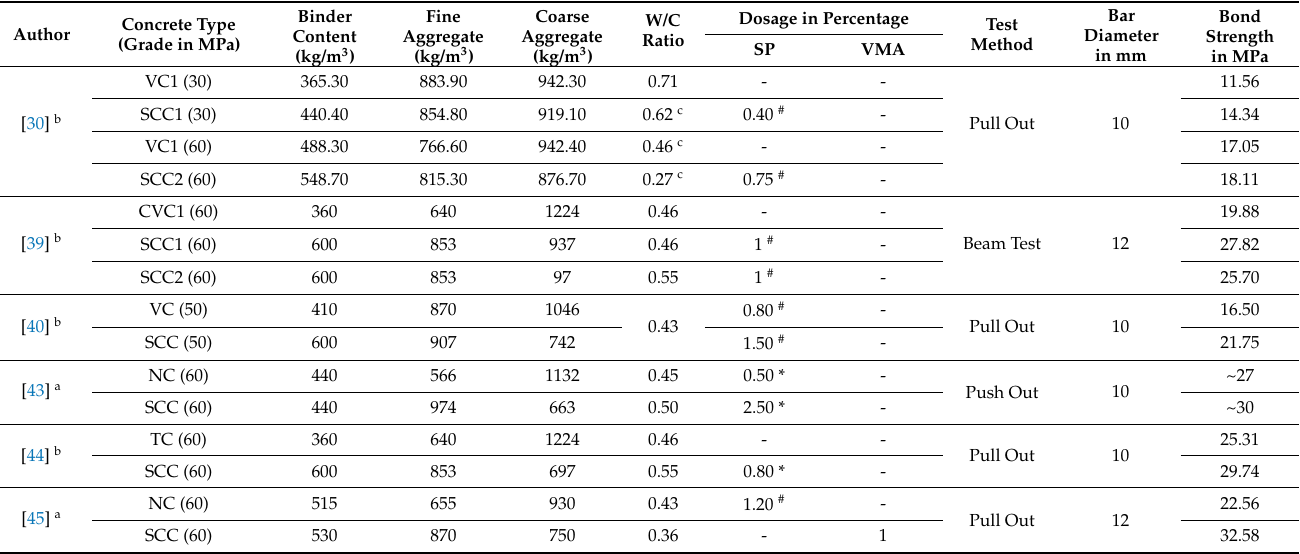
Table 3. Comparing bond strength discussed in the